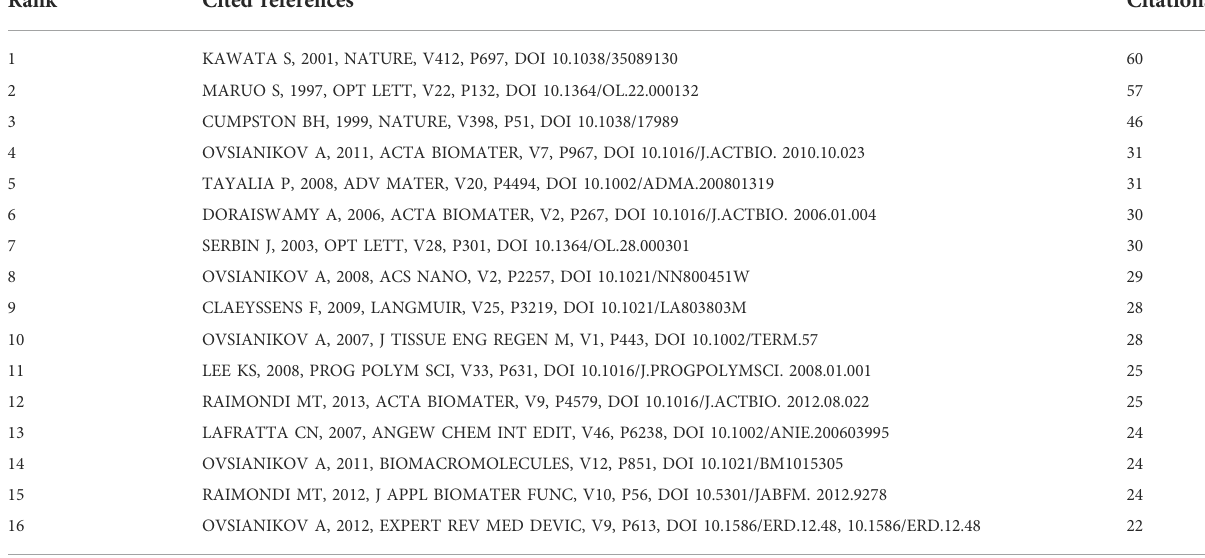
TABLE 3 The top 10 most cited references cited by publications on applications of TPP in biomedical fi eld.